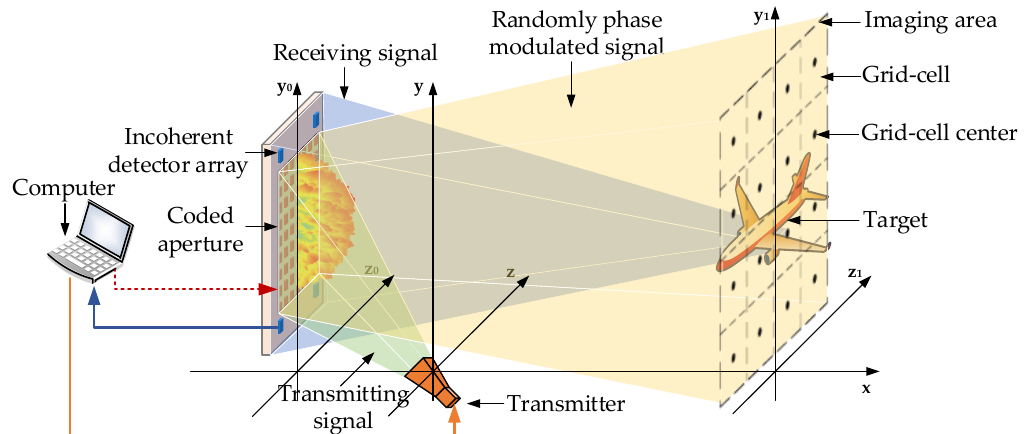
Figure 1. The architecture of the phaseless terahertz coded-aperture imaging (PL-TCAI) system based on combination of incoherent detector array and reflectarray coded aperture.